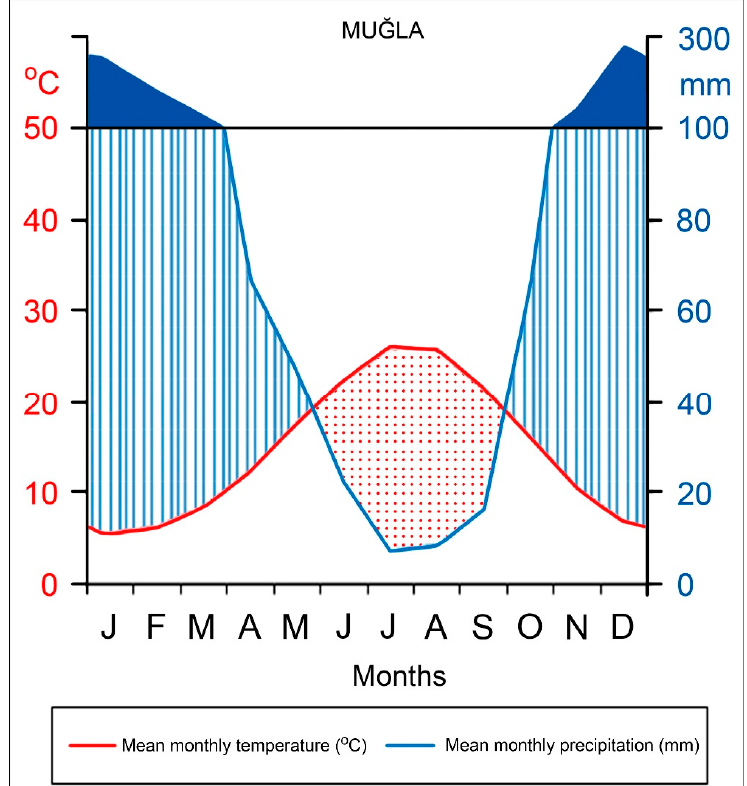
Figure 9. Monthly total precipitation and mean temperature values (1936–2006) (Climate diagram) of the Mu ğ la meteorological station. Red and blue areas indicate dry and wet conditions respectively.